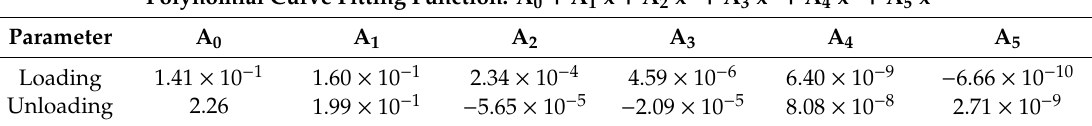
Table 6. 5th Polynomial function and